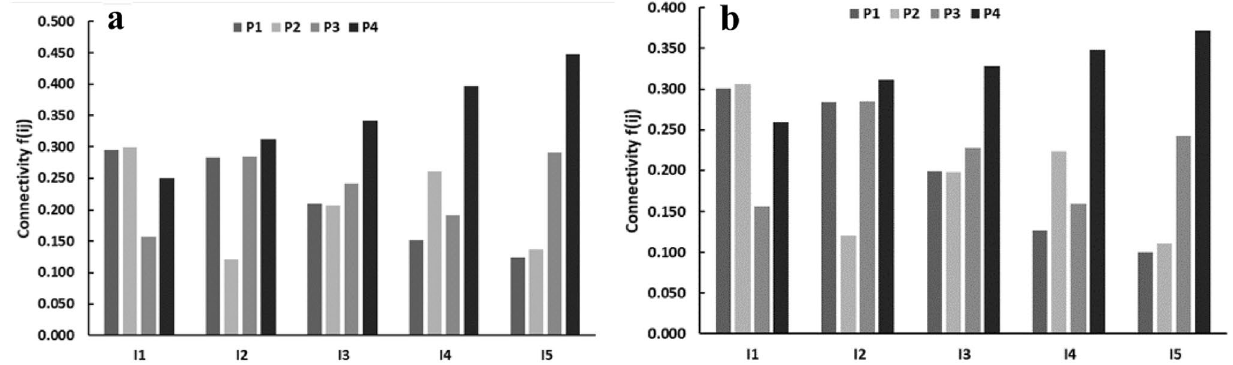
Fig. 7 Connectivities estimated by a) D-CRMP b) CRMP for case I